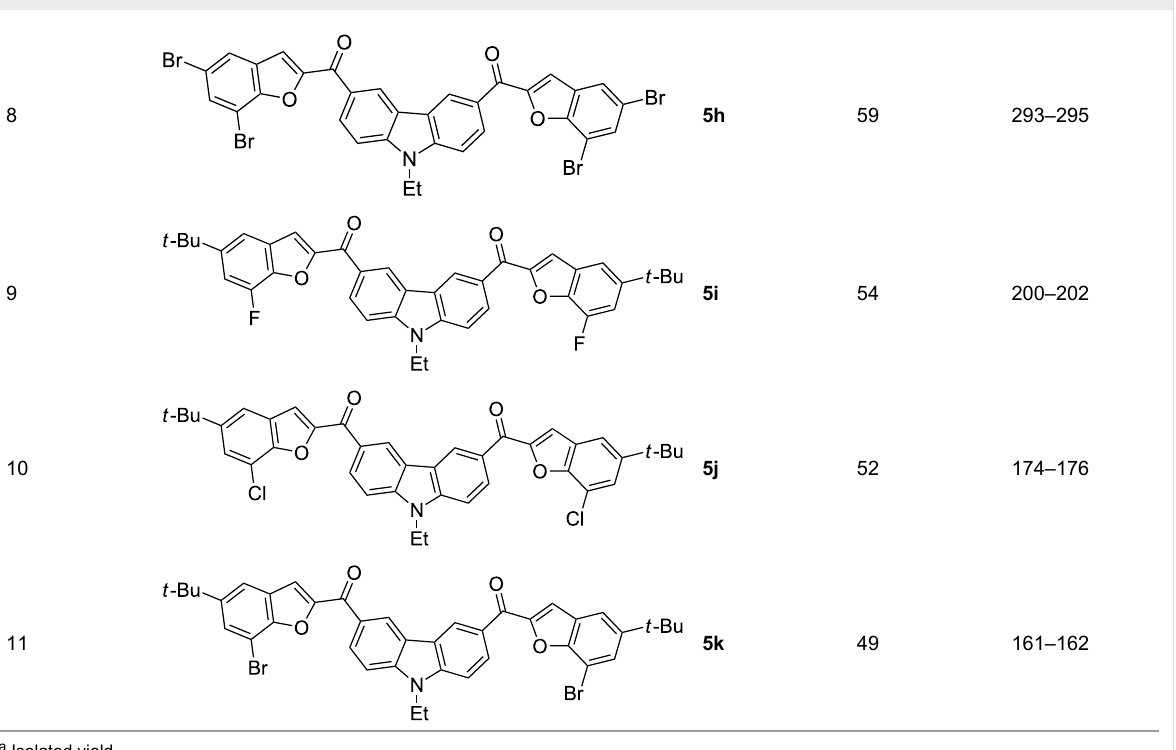
Table 2: Synthesis of 3,6-bis(2-benzofuroyl)carbazole derivatives ( 5a – k ).